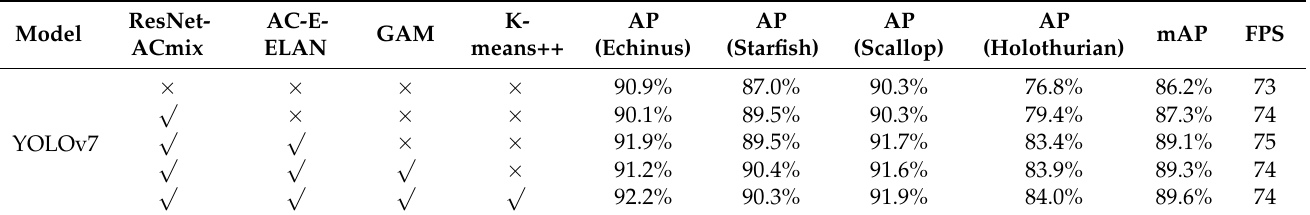
Table 4. Ablation comparison of model performance improvement on the URPC